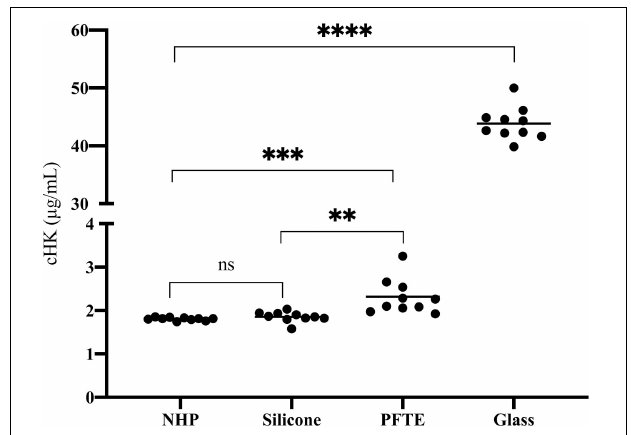
FIGURE 7 | The effect of artificial surfaces on the plasma concentration of cHK. The effect of silicone ( n = 10), polytetrafluoroethylene (PFTE) ( n = 10) and glass ( n = 10) on cHK concentrations in normal human plasma (NHP) after incubation for 2 h were compared to control NHP without incubation ( n = 10). No significance (ns) Silicone compared to NHP. ∗∗ p = 0.003 Silicone compared to PFTE. ∗∗∗ p = 0.001 PFTE compared to NHP. ∗∗∗∗ p < 0.0001 Glass compared to NHP. Horizontal lines indicate the mean